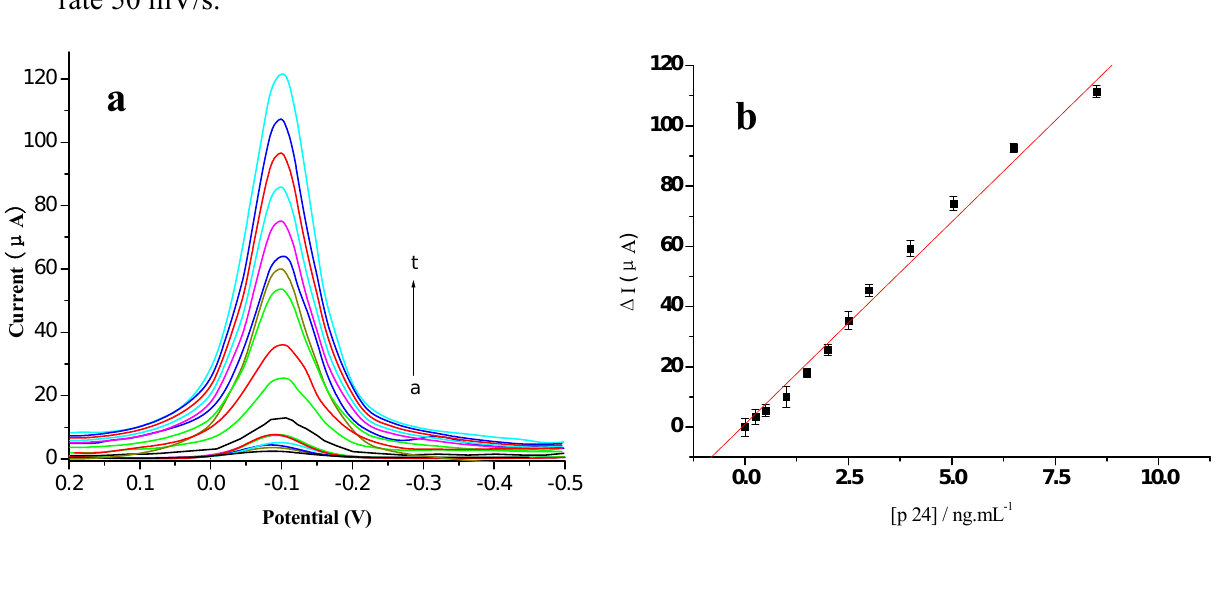
Figure 8. Voltammogram of the modified electrode using different concentrations of antigen (0~10 ng/mL, respectively) ( a ) DPV curves; ( b ) plot of Δ I vs . the concentrations of p24. All experiments were carried out in 0.01 mol/L PBS, 0.1 mol/L KCl (pH 7.4) and O , at a potential range of 0.2 V to − 0.5 V, vs. SCE. Scan added 5 mmol/L HQ and H 2 2 rate 50